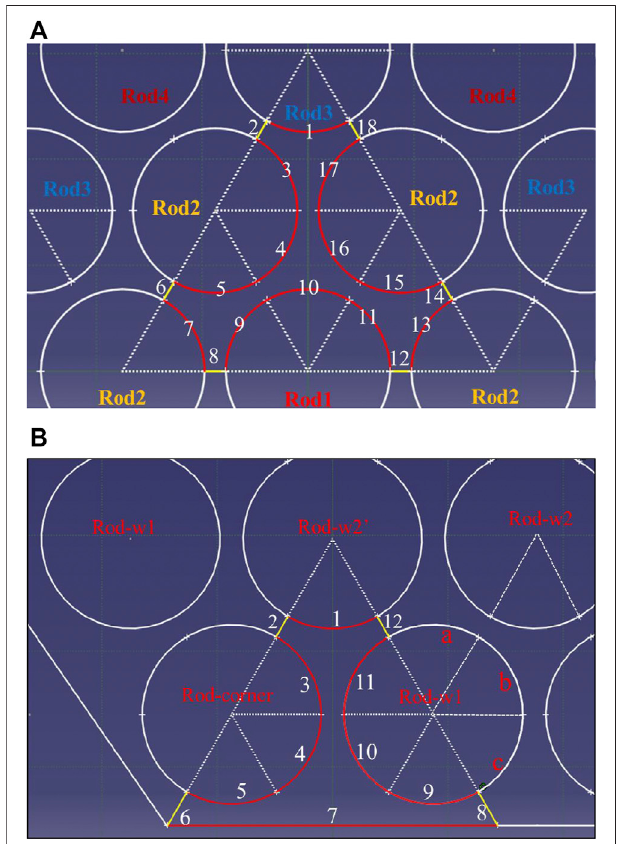
FIGURE4| Basicunitforanalyzing (A) therod-to-rodabsorptionfactors and (B) the rod-to-wall absorption